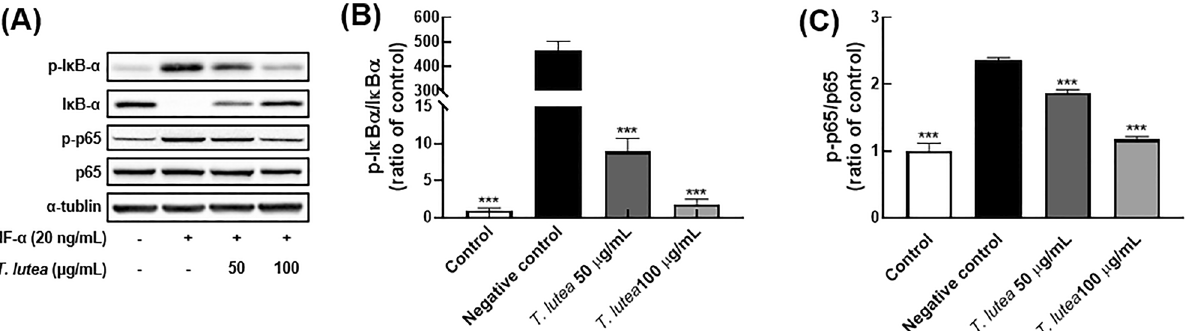
Figure 4. Comparative analysis of NF-κB protein expression in ARPE-19 cells following TNF-α-induced inflammation. ( A ) Western blot comparison of protein expression. Quantitative comparison of phosphorylation